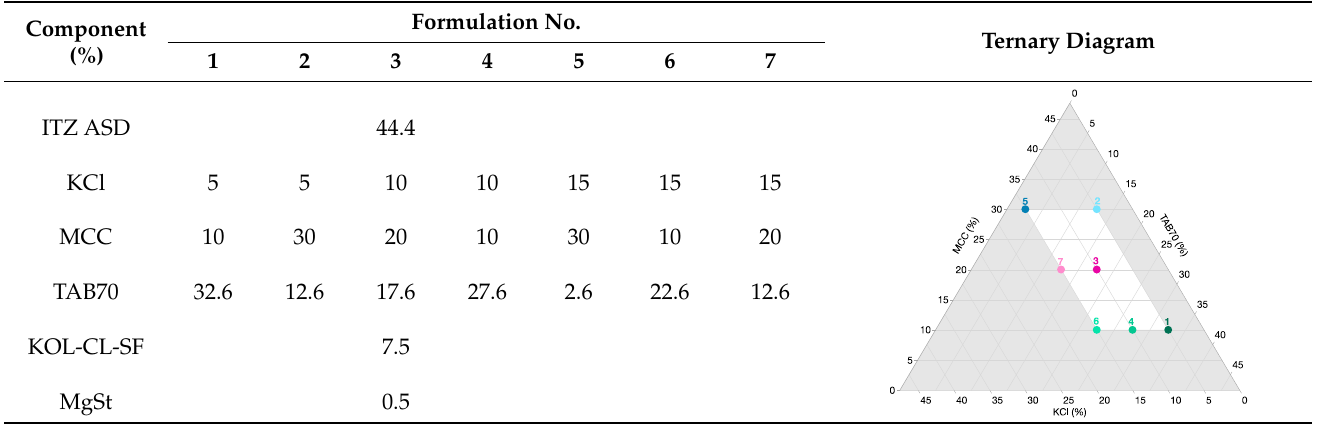
Table 4. Mixture design and ternary plot for ITZ ASD tablets formulations.